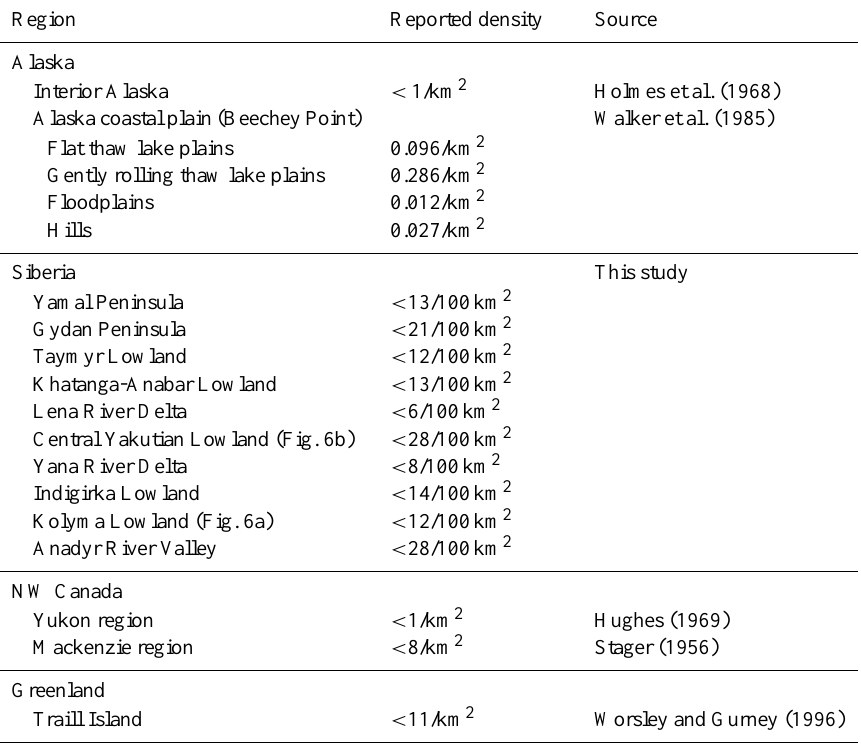
Table 4. Spatial pingo densities reported from various regions. Depending on study area size and sometimes focus on particular landscape units densities are reported as pingos per km 2 (detailed assessment of small areas or landscape units) or pingos per 100km 2 (averaging over large